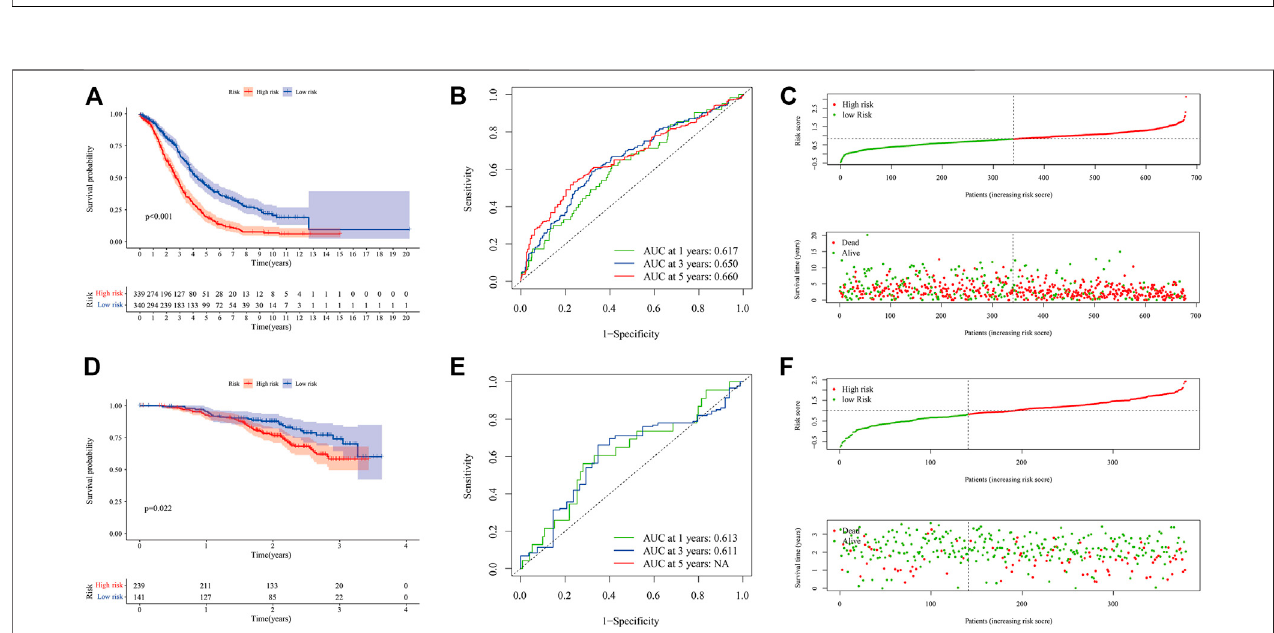
FIGURE 7 | Evaluation and external veri fi cation of prognostic models of immune-related genes. (A – C) show the analysis result of GSE18520, GSE26193, GSE19829, GSE30161, GSE63885, and TCGA-OV data set. (A) Kaplan-Meier curve (6 independent OC data sets). (B) ROC curves. (C) Scatter plot of the risk score and overall survival. (D – F) show theanalysis resultofGSE140082. (D) Kaplan-Meier curve (externalveri fi cation). (E) ROCcurves(external veri fi cation). (F) Scatter plotof patient risk score and overall survival (external veri fi cation).